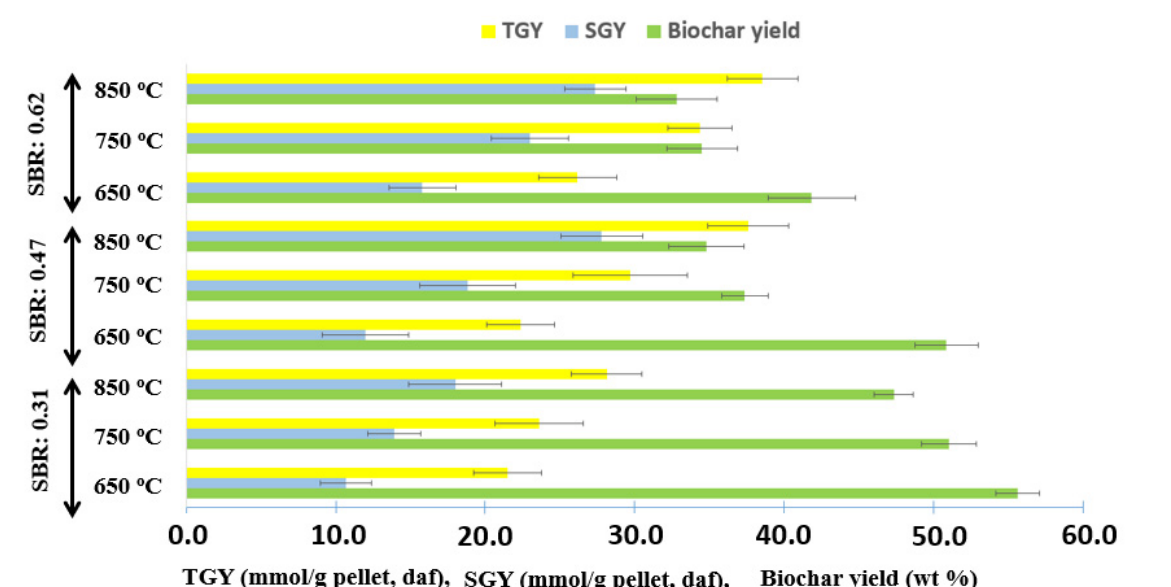
Figure 2. Total gas yield (TGY), syngas yield (SGY), and biochar yield for the steam gasification of fuel pellets at different gasification temperatures and steam-to-biomass ratios.